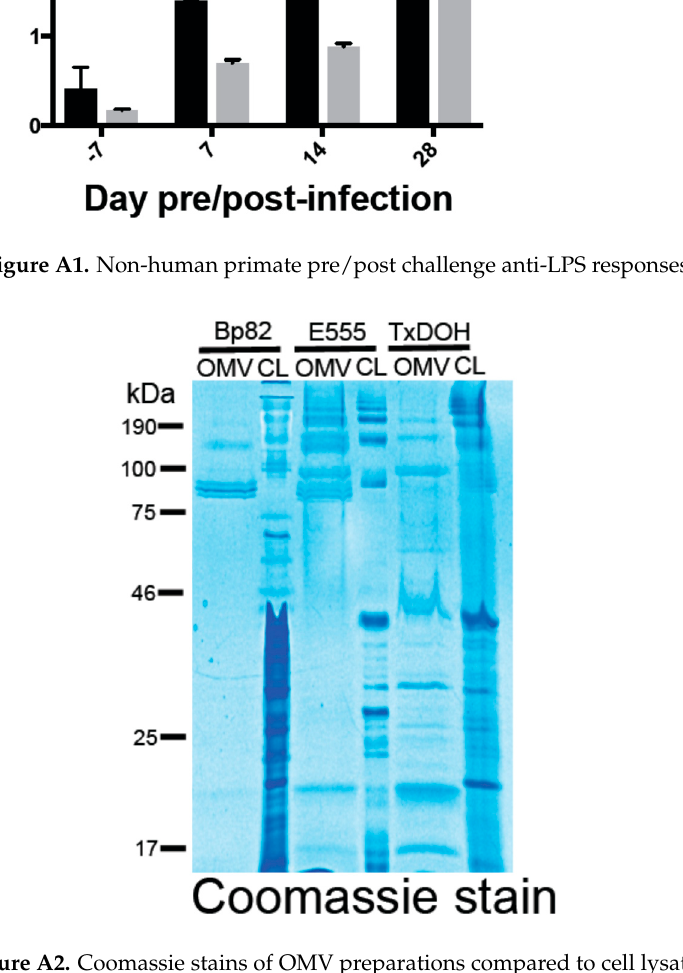
Figure A2. Coomassie stains of OMV preparations compared to cell lysates.